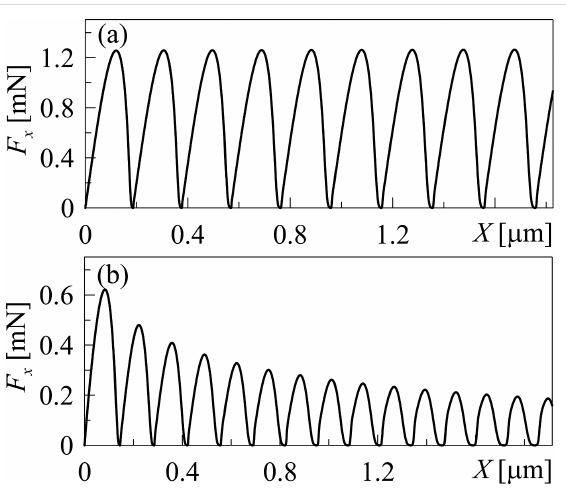
Figure 5: (a) Dependence of the friction force F x on the stamp coordi- nate X (upper friction surface), corresponding to Figure 2a. (b) Depen- dence of the friction force F x on the stamp coordinate X , correspond- ing to Figure